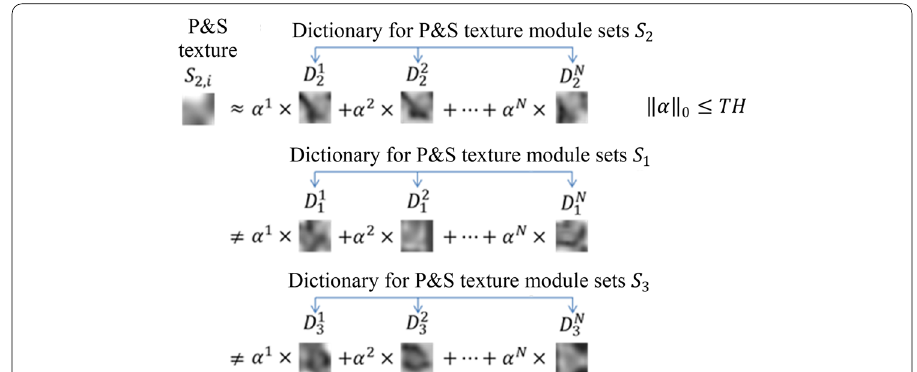
Fig. 7 Concepts of the proposed pattern recognition method: an input texture module will be recognized as one type of texture pattern, whose dictionary can represent the P&S module with the smallest